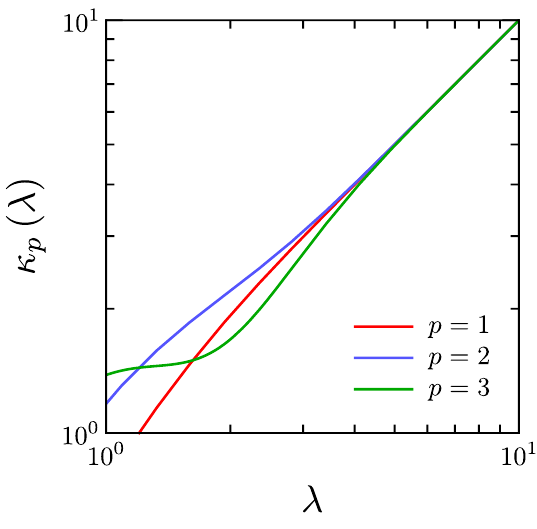
Figure 7 . Cumulants of the EP distribution as a function of the parameter λ = Np . For large values of λ , all cumulants approach the mean of the distribution h n i = λ tanh( λ )